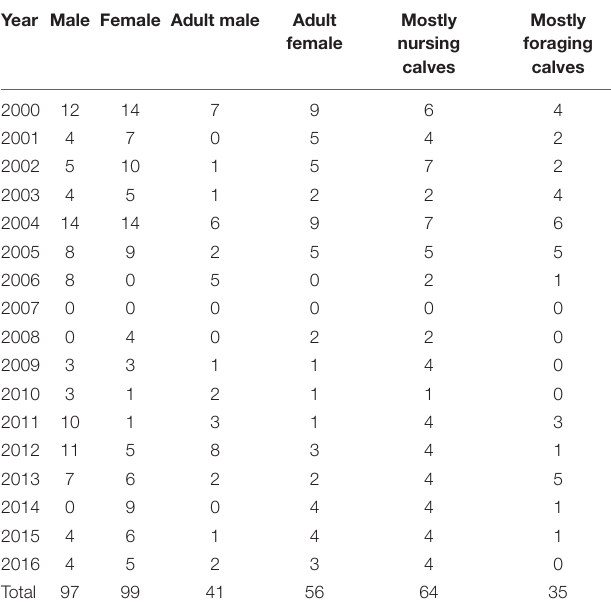
TABLE 1 | Number of common bottlenose dolphin samples collected per year by sex and age